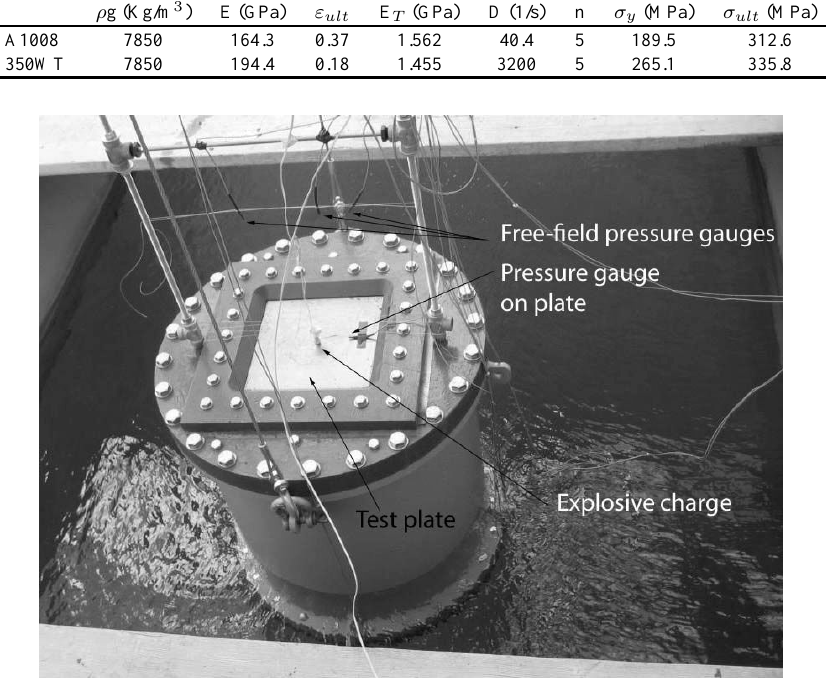
Fig. 1. Apparatus for performing underwater explosion testing of square